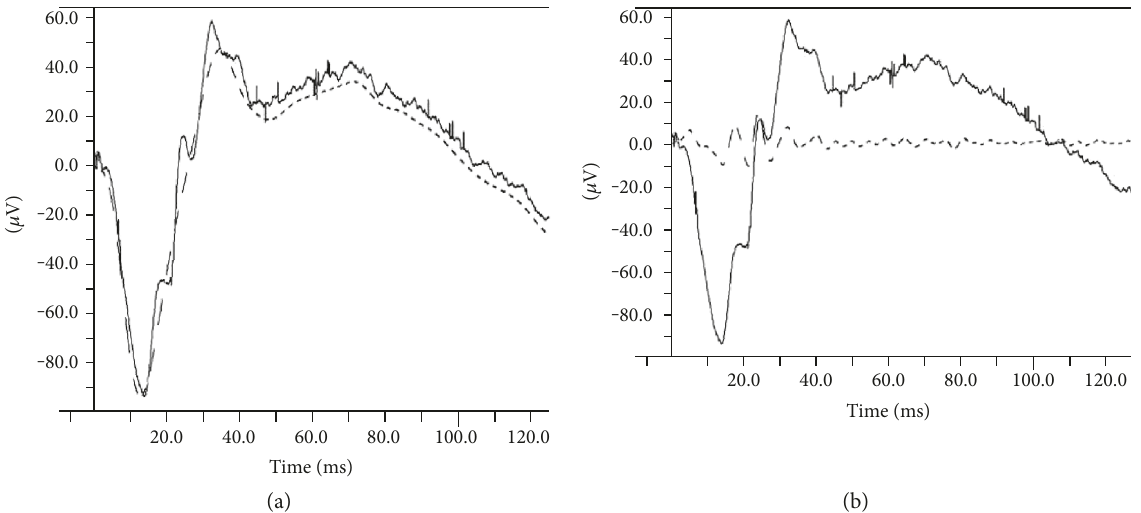
Figure 5: The WDS is not part of the oscillatory potential complex. (a) Low-pass fi ltering ( < 100Hz) of a representative trace (3 cd ∗ s/m 2 ). The WDS is seen in both the un fi ltered (solid line) and the fi ltered (dashed line) traces, while the oscillatory potentials are seen superimposed on the ascending limb of the un fi ltered b-wave only. (b) High-pass fi ltering ( > 100Hz, dashed line) of the same trace shown in panel (a), demonstrating no high-frequency components of the WDS, while the oscillatory potentials are clearly seen. The un fi ltered trace is once again shown as a solid line.